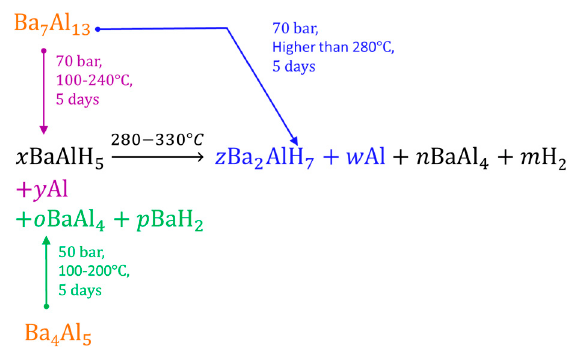
Figure 18. Production of BaAlH 4 or B 2 AlH 7 from hydrogenation of Ba 7 Al 13 or Ba 4 Al 5 .